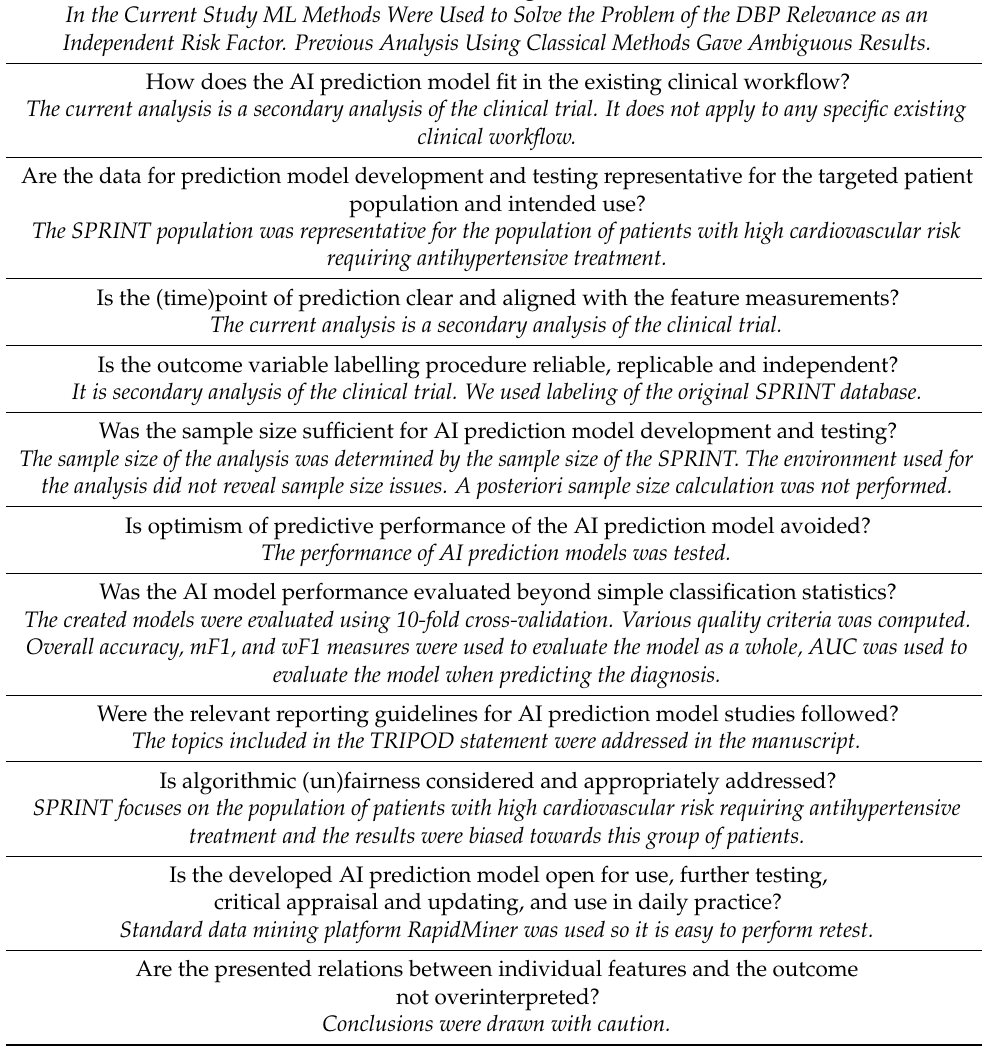
Table 3. Questions about artificial intelligence-based prediction of cardiovascular disease. Is AI Needed to Solve the Targeted Medical